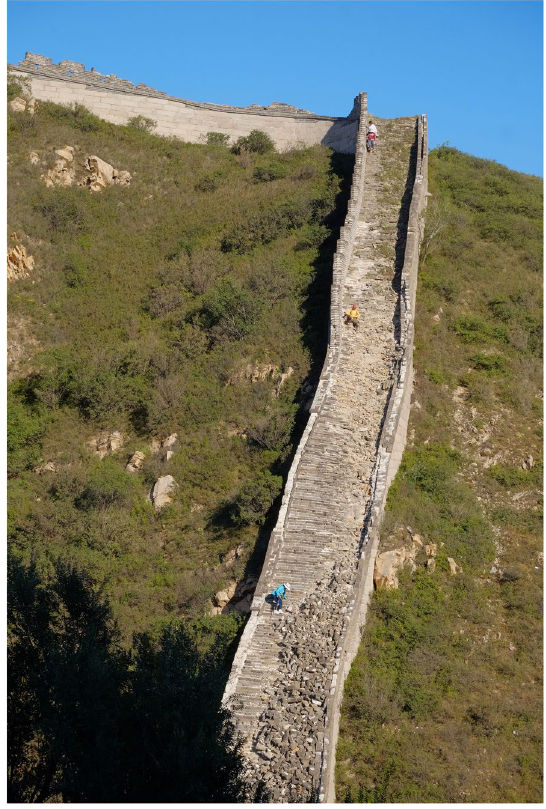
Fig. 8 A part of the Ming Great Wall in Beijing (before restoration in 2019), both sides of which were built with granite, brick and dolomitic lime mortars (Source: